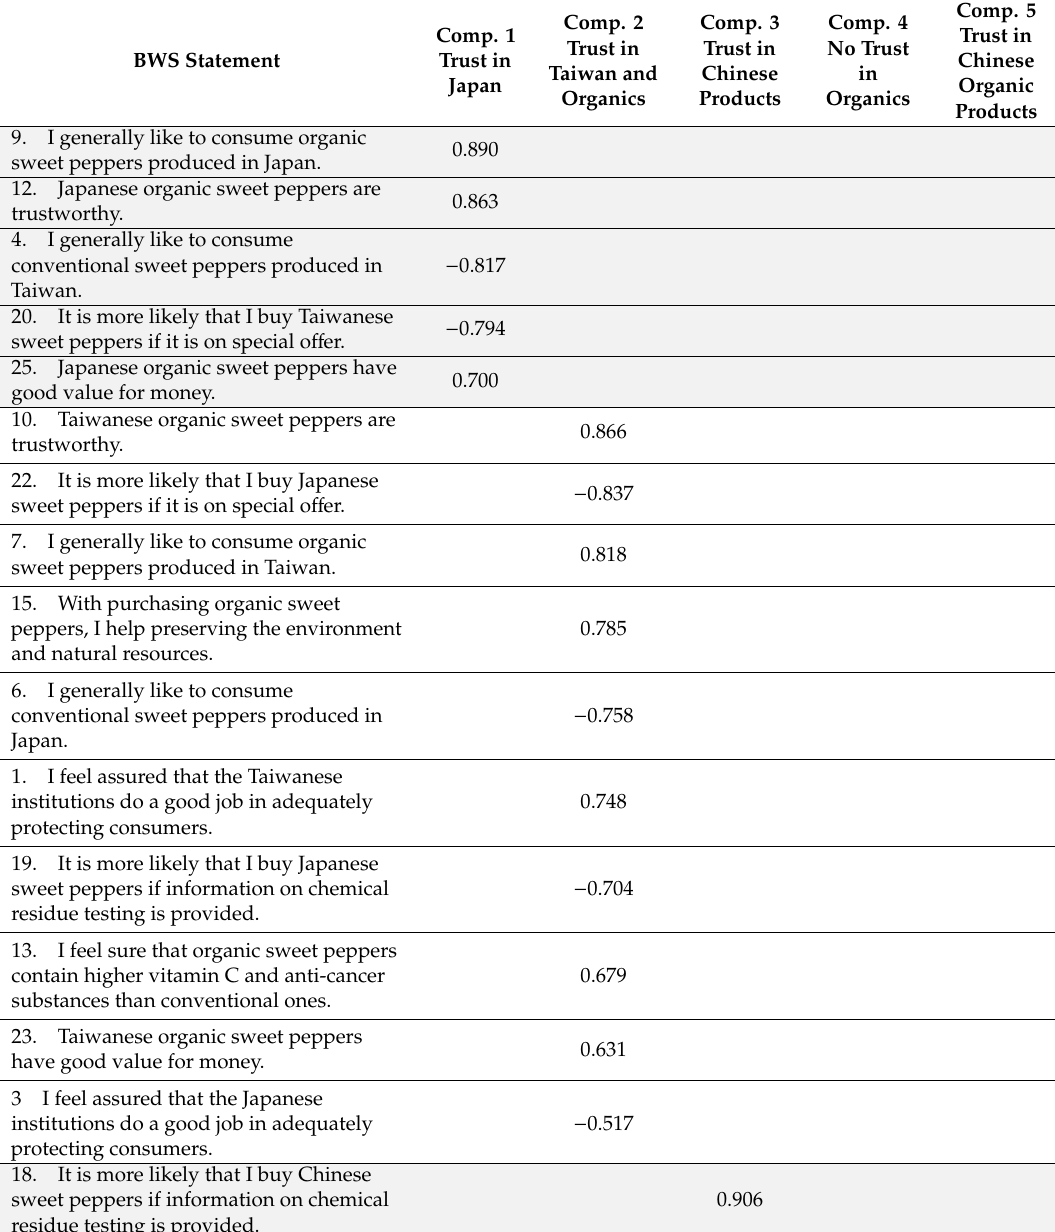
Table 8. Principal component analysis with oblimin rotation of 25 BWS items. Comp.